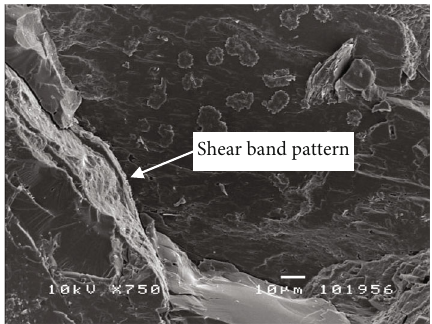
Figure 18: Shear band pattern (-30 ° C, × 750).